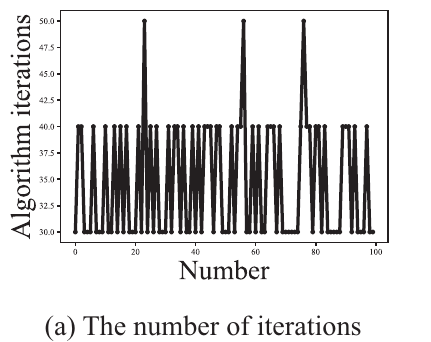
Figure 8. Sorting and memory functions of ESMS.